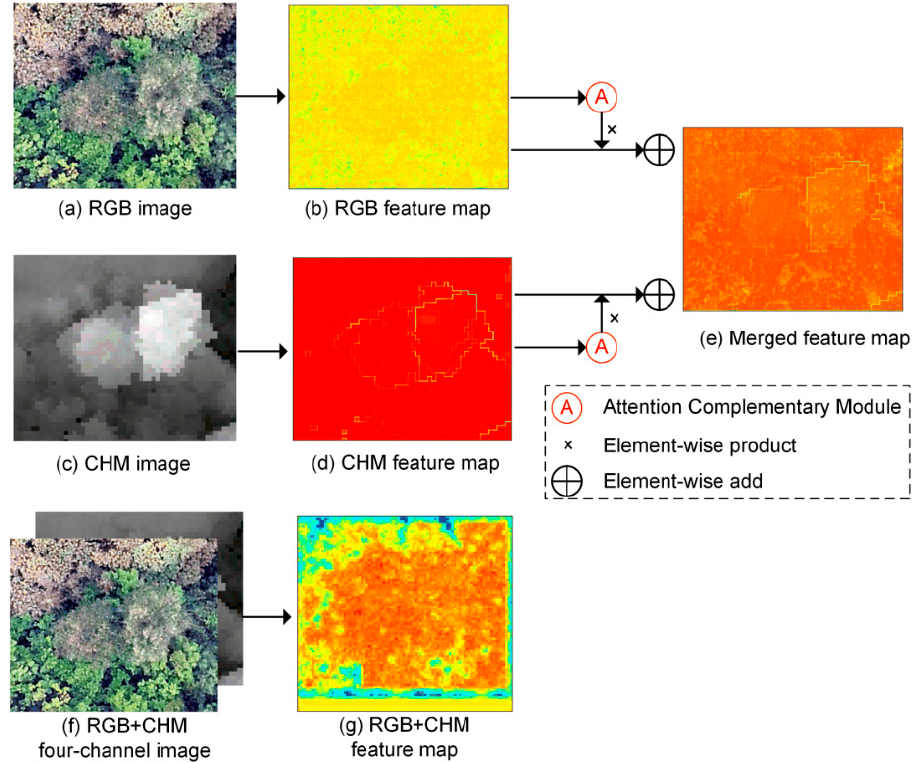
Figure 10. Feature map extracted by ACNet ( a – e ) and ResNet50-FPN ( f , g ). ( b , d , e ) Feature map extracted from the RGB branch, CHM branch, and fusion branch of ACNet, respectively. ( g ) Feature map extracted by ResNet50-FPN.